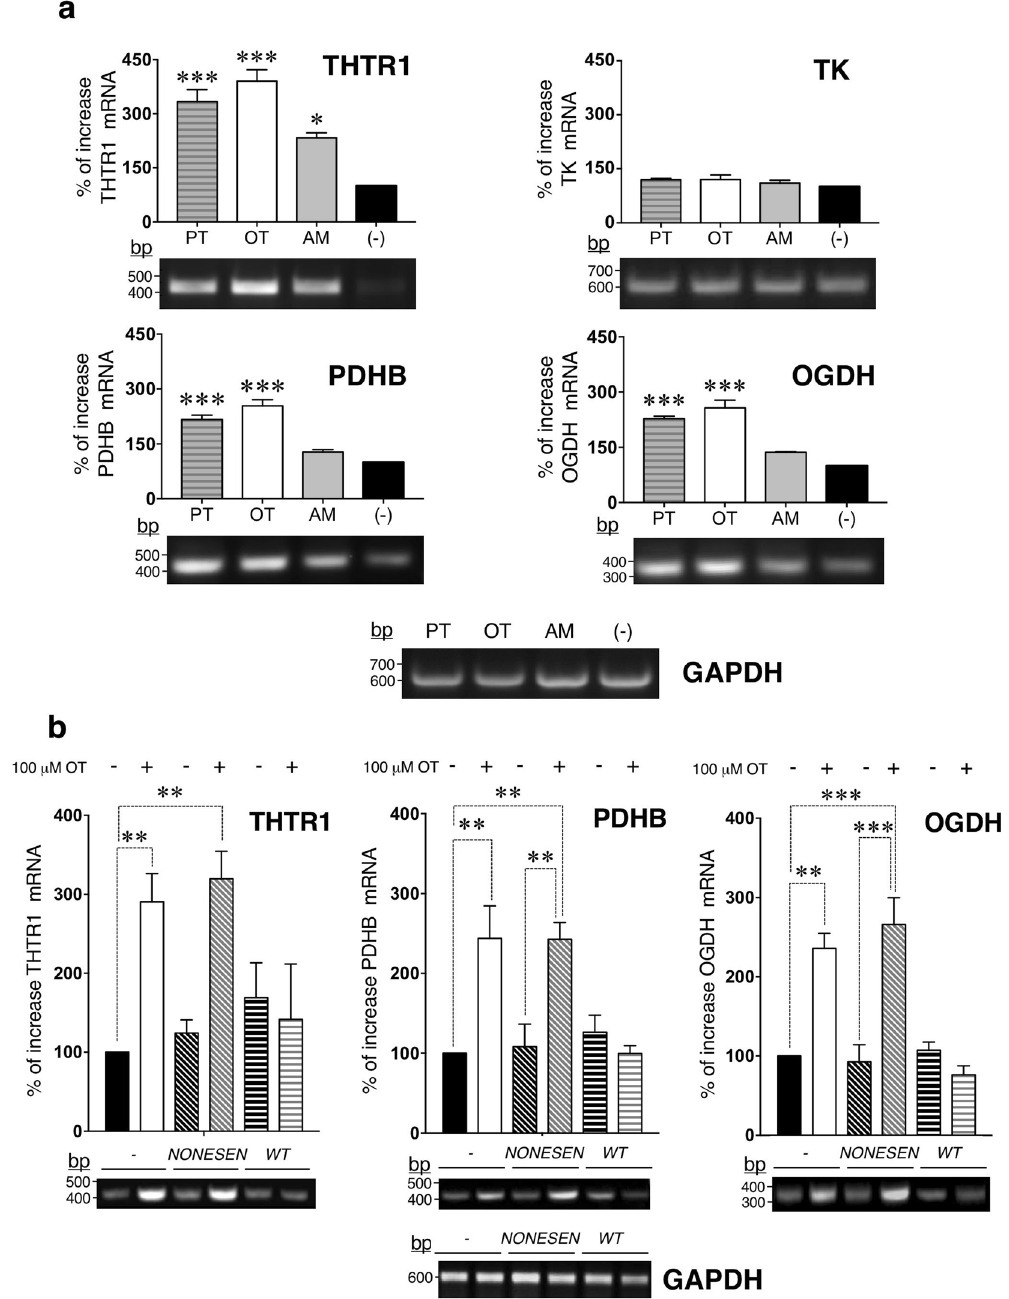
Figure 2. p53-dependent regulation of the expression of proteins involved in metabolism and functioning of thiamine by OT. Differentiated SH-SY5Y cells were treated with ( a) 100 μ M PT, OT and AM. THTR1, TK, PDHB, OGDH gene expression were determined by RT–PCR. ( b) Differentiated SH-SY5Y cells were collected, electroporated with 1 μ M of p53 decoy (wt) or nonsense oligonucleotide (nonsen) followed by treatment with 100 μ M OT. THTR1, PDHB, OGDH gene expression were determined by RT–PCR. All presented data ( a , b ) were normalized to GAPDH and expressed as the percentages of increase over non-treated cells ( − ). One way ANOVA and Bonferroni post-testing ( * P < 0.05, ** P < 0.01, * ** P < 0.001) indicates statistically significant differences between samples (n =